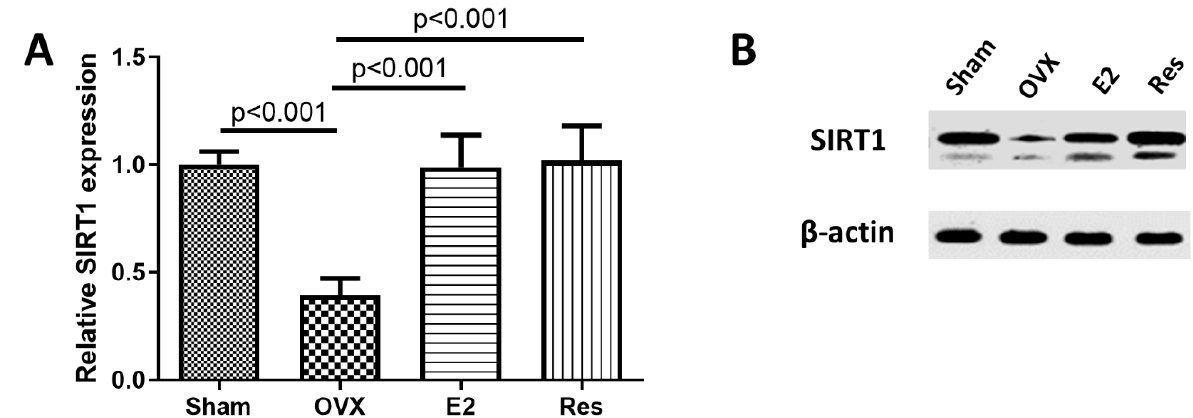
Figure 1. Resveratrol and E2 upregulated SIRT1 protein expression in the aortas of ovariectomized rats. ( A ) Relative SIRT1 protein expression, normalized to β -Actin (arbitrary units). ( B ) Representative Western blot images. OVX: ovariectomized rats; E2: estradiol; Res: resveratrol. Graphs show mean ± SD, n = 6.